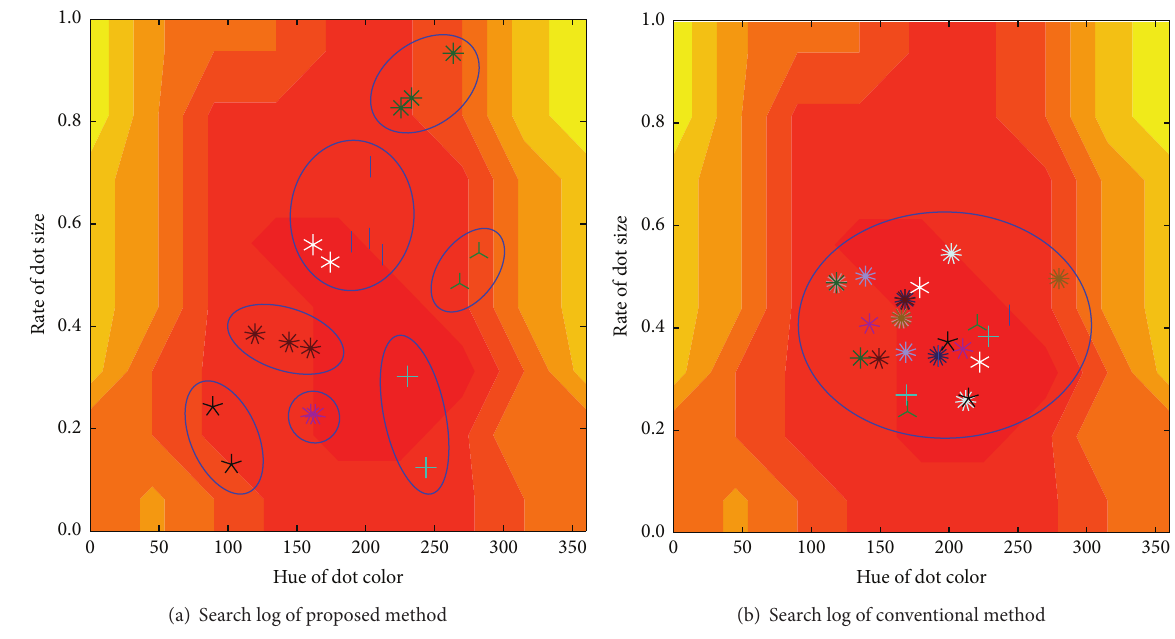
Figure 22: Search logs of the last generation for the unimodal landscape (for the dotted